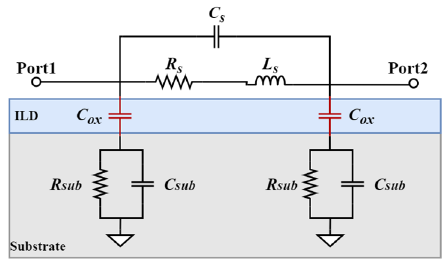
Figure 6. Single π circuit model. Table 3. The ratio of capacitance before and after metal filling for different metal filling densities.